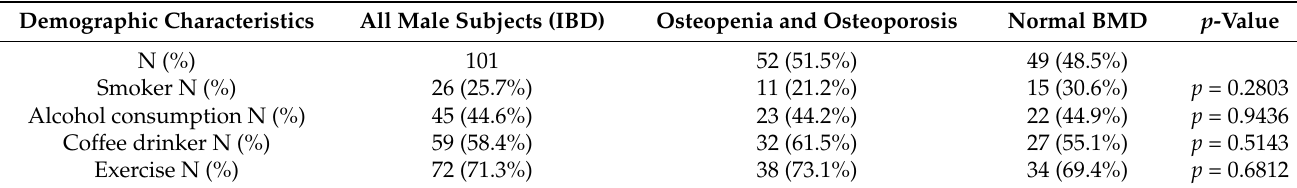
Table 9. The lifestyle parameters of the studied IBD male patients with respect to osteoporosis and osteopenia. Demographic